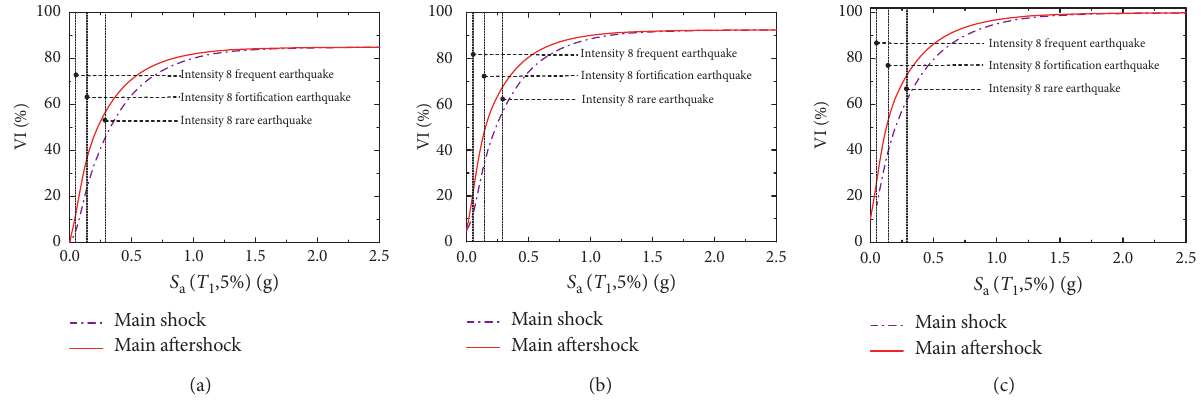
Figure 19: Vulnerability index curves. (a) Lower limit value. (b) Mean value. (c) Upper limit